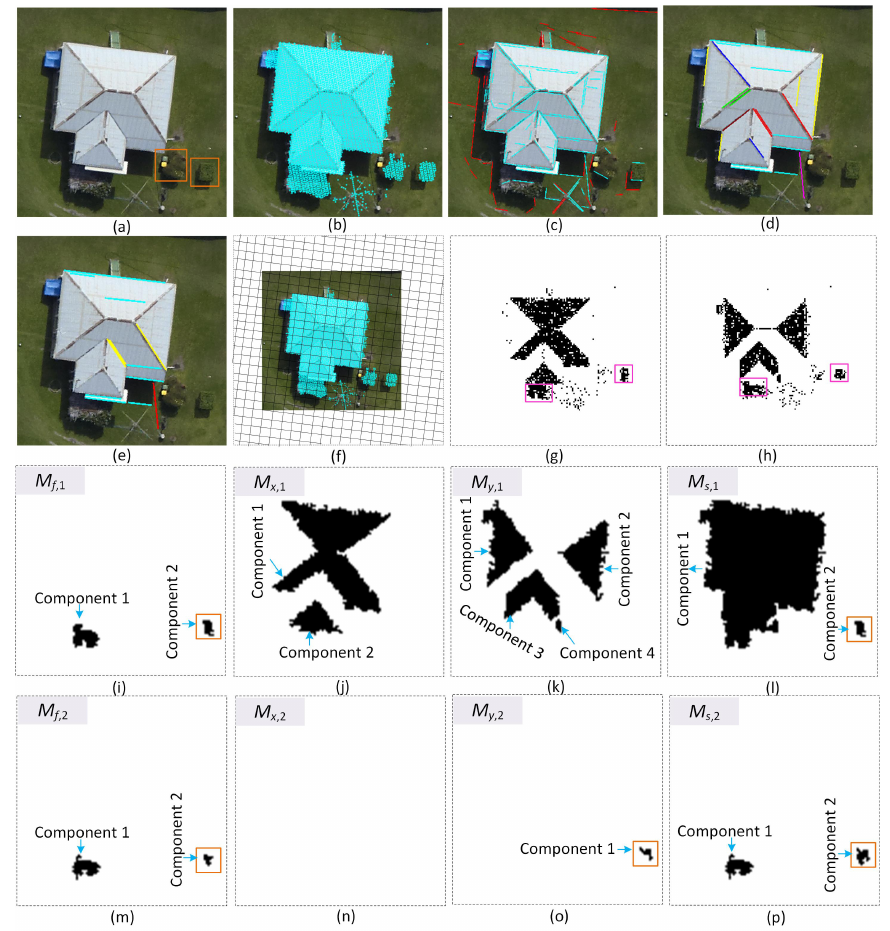
Figure 3. Proposed mask generation from a sample scene: (a) aerial image, (b) non-ground points, (c) all image lines (red for ground and cyan for non-ground lines), (d) long lines in eight histogram bins are shown in different colours (lines are at least 3 m in length), (e) lines in two bins (cyan and yellow) for which two actual dominant directions are estimated (red line shows a non-dominant direction), (f) temporary sub-mask M ts,i rotated at the first dominant direction ( φ 1 = 173 . 6 ◦ ), (g) gradient image F x, 1 , (h) gradient image F y, 1 , (i) flat areas M f, 1 , (j) sloppy areas M x, 1 along φ 1 , (k) sloppy areas M y, 1 across φ 1 , (l) sub-masks M s, 1 , (m) flat areas